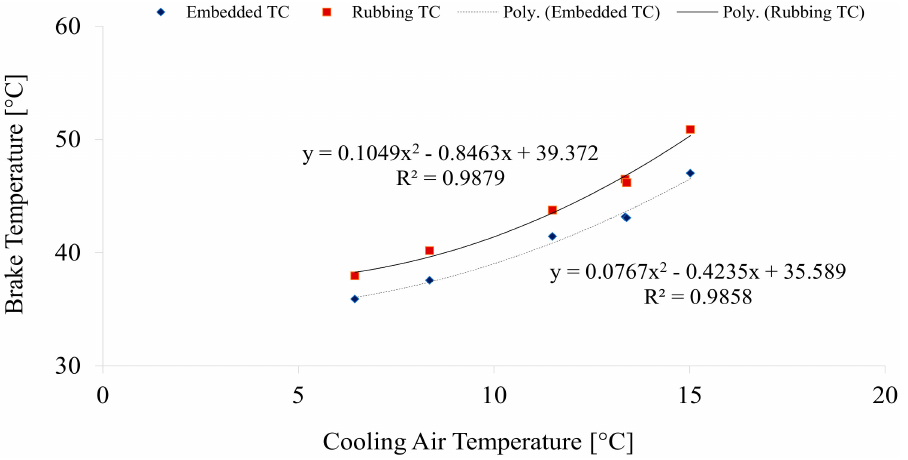
Figure 6. Average brake temperature from EED file at 1 Hz as a function of incoming air temperature—the trendlines represent polynomial models for both